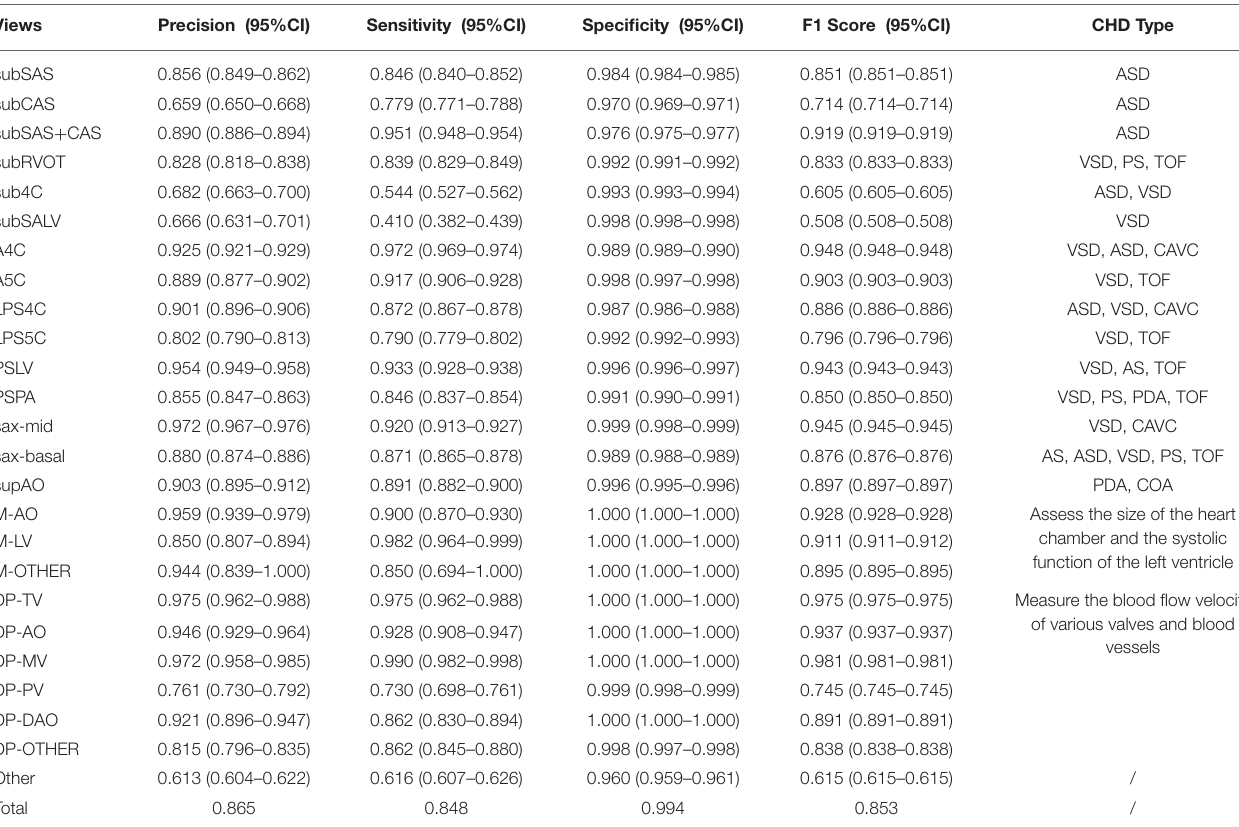
TABLE 3 | Performance evaluation for different